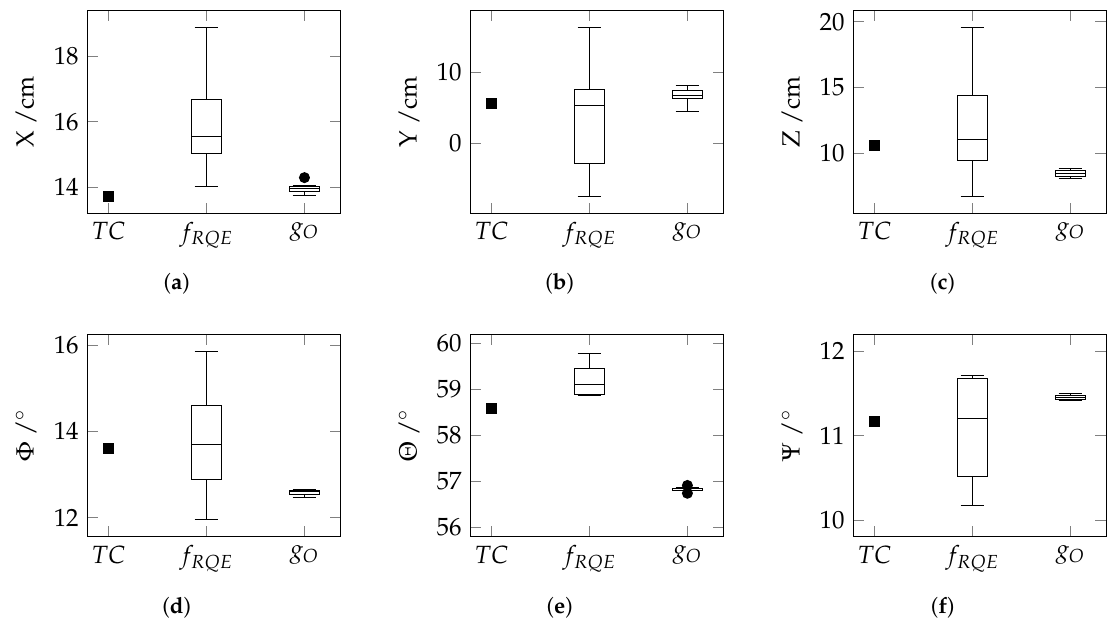
Figure 8. Calibration results of the different approaches for the small-scale indoor dataset. ( a – c ) show the translation parameters, ( d – f ) show the rotation parameters. For the TC, only a single set of parameters is available without information about the precision. The medians of multiple calibrations differ significantly from the results of the target-calibration. The self-calibration based on omnivariance g O estimates all parameters with higher precision compared to the calibration based on RQE